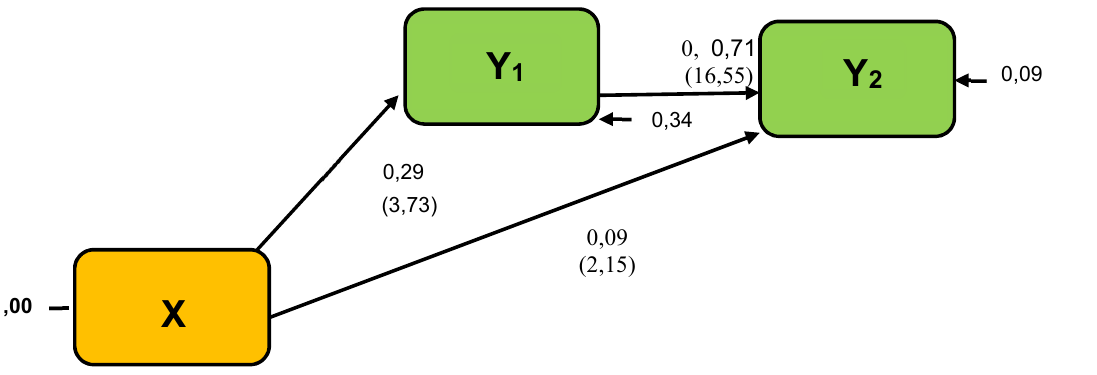
Fig. 1. Path coefficients with T count and T table Effect of Organizational Justice on Work Involvement and OCB Chi-Square = 0.00, df = 0, P-value = 1.0000, RMSEA =